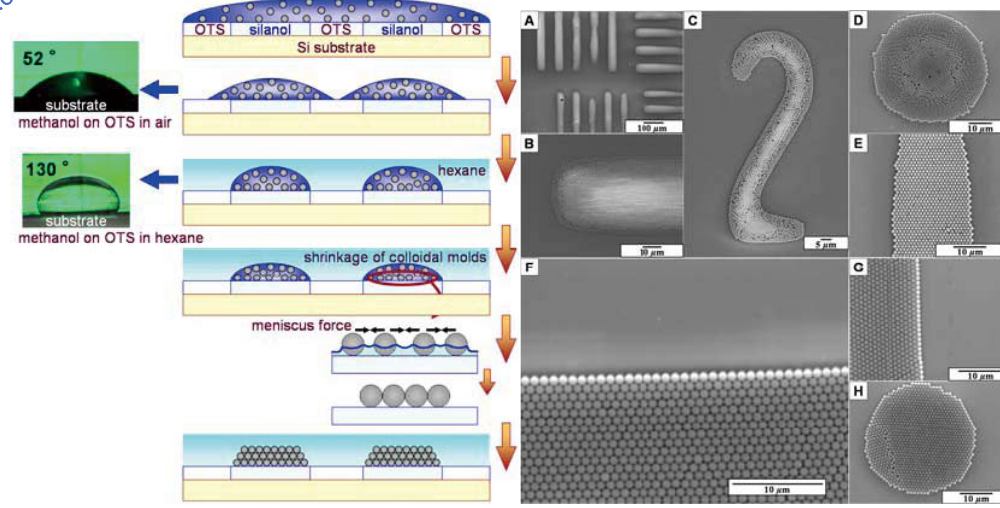
Fig. 1 Micropatterns of colloidal